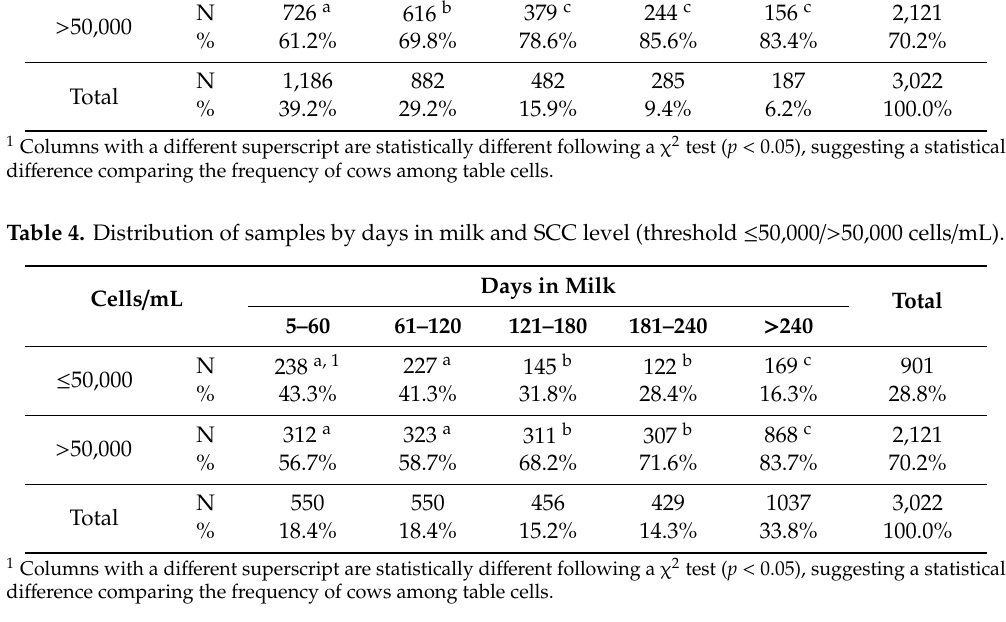
Table 3. Distribution of samples by number of parturitions and SCC level (threshold ≤ 50,000 /> 50,000 cells / mL). Cells / mL